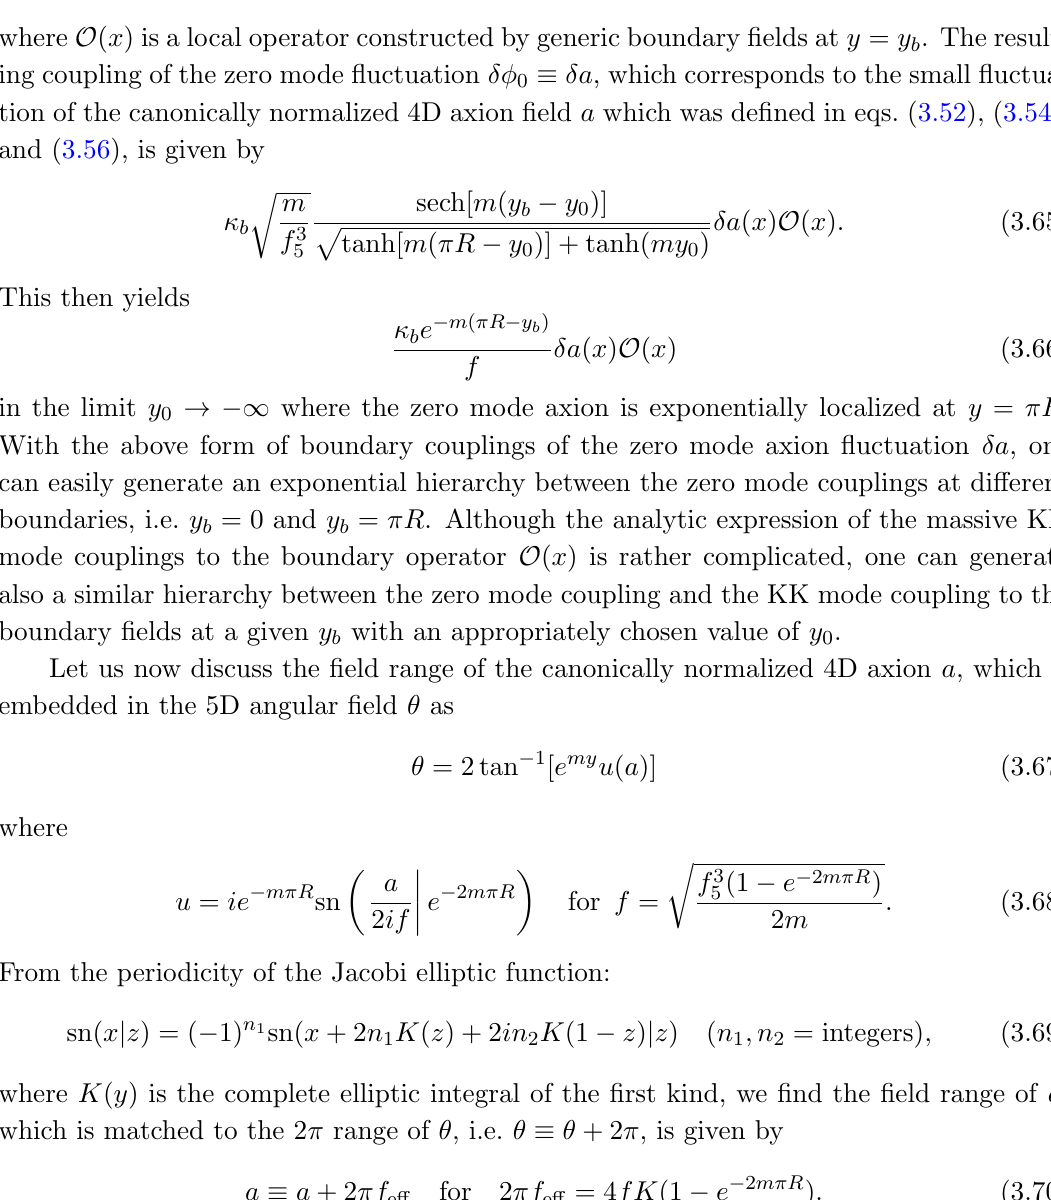
Figure 4 . Wavefunction pro(cid:12)le (3.62) for the zero mode (cid:13)uctuation ( n = 0: red) and massive mode (cid:13)uctuations (n=1 ; 2 ; 3: blue) for y 0 = 2 (cid:25)R (left), y 0 = (cid:25)R= 2 (middle) and y 0 = 0 (right). For illustration, we take mR =